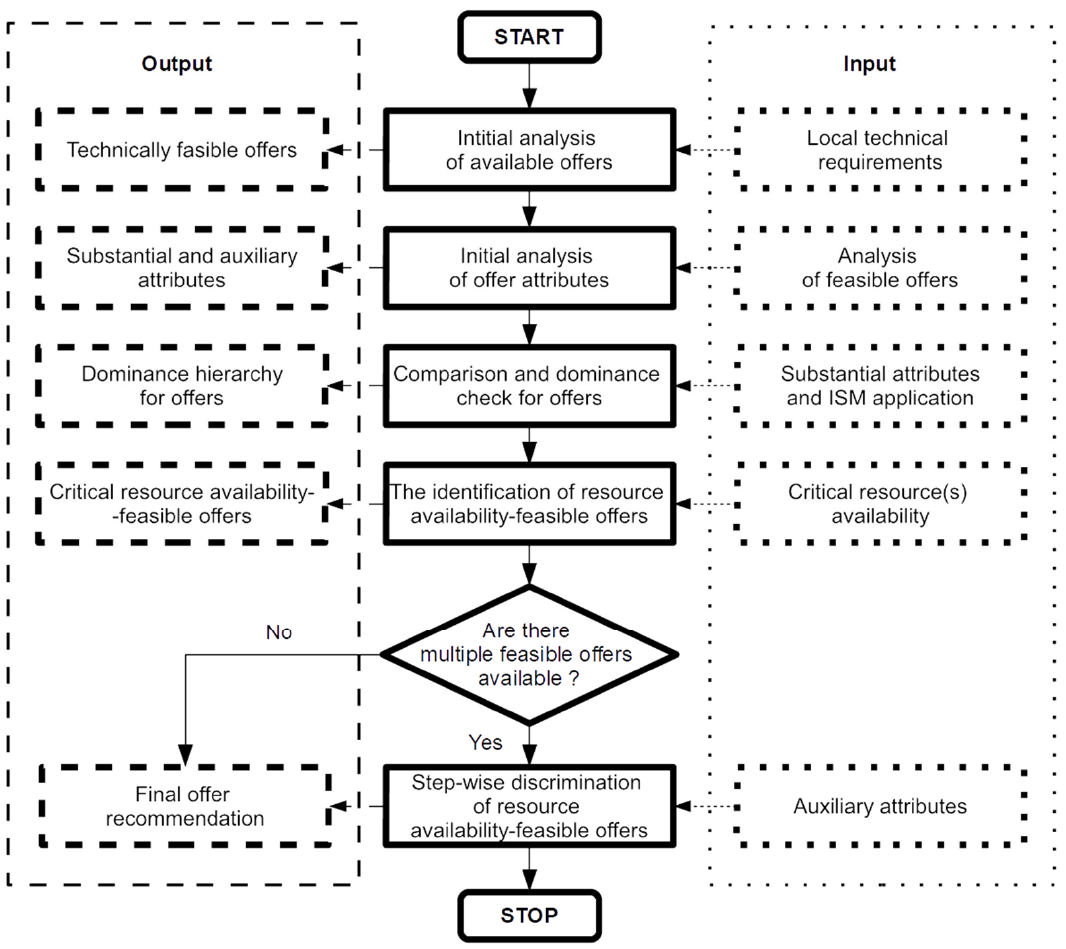
Figure 1. Proposed procedure scheme.